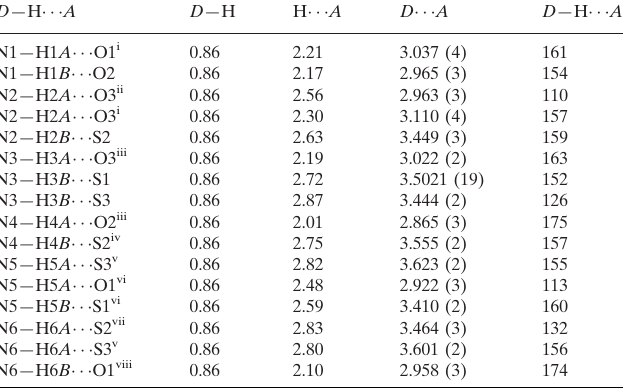
Hydrogen-bond geometry (A ˚ , (cid:3)